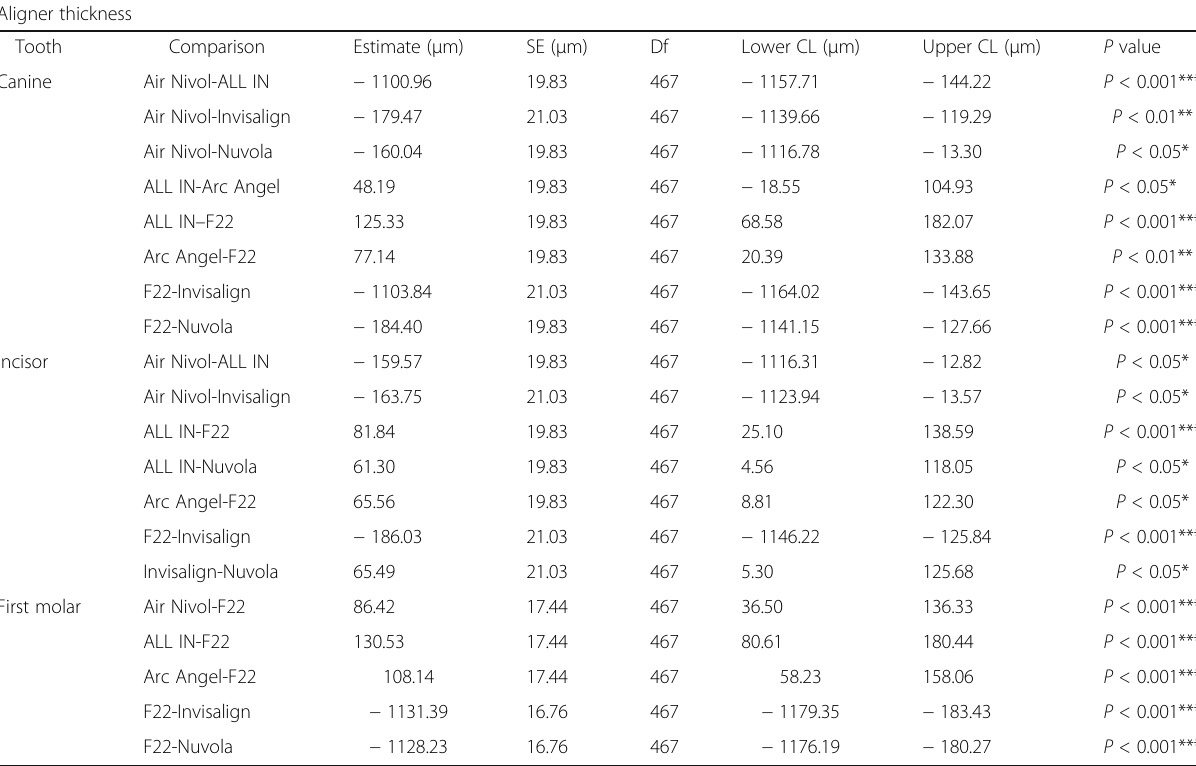
Table 5 Statistically significant comparisons for the aligner thickness measure ( P < 0.05*, P < 0.01**, P < 0.001***) Aligner thickness Tooth